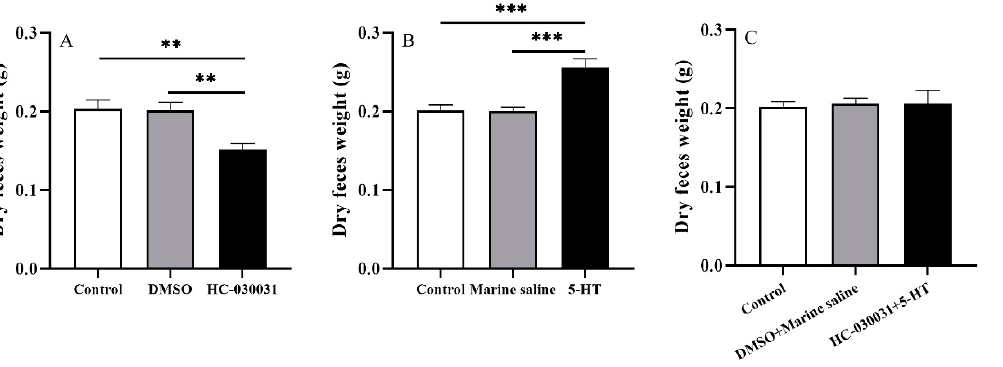
Figure 6. Gut emptying is positively correlated with the reciprocal regulation of TRPA1 and 5-HT in the gut of Strongylocentrotus intermedius. ( A ) Dry weight of the 48-h accumulated feces of the control, DMSO, and HC-030031 groups ( n = 5). ( B ) Dry weight of the 48-h accumulated feces of the control, marine saline, and 5-HT groups ( n = 5). ( C ) The dry weight of the 48-h accumulated feces of the control, DMSO + marine saline, and HC-030031 + 5-HT groups ( n = 5). The symbols ** and *** mean p < 0.01 and p < 0.001, respectively (mean ± s.e.m.).